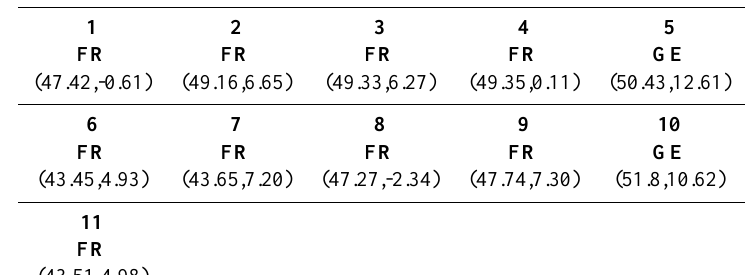
Table 1. Summary of the experiments used to identify the influence of the BECM parameters. “diag.” means that the parameter was calculated from a posteriori diagnostics; “ens.” means that the parameter was calculated from an ensemble of realizations. Experiments D IRECT P ERCENT O PER S TD L XY S TD L XY Length-scale – 45km 45km 45km ens. ens. Std – 20% diag. ens. diag. ens. Table 2. Coordinates of the validation stations; 1–5 both for summer and winter periods, 6–10 only for summer period, 11 only for winter period; FR for France and GE for